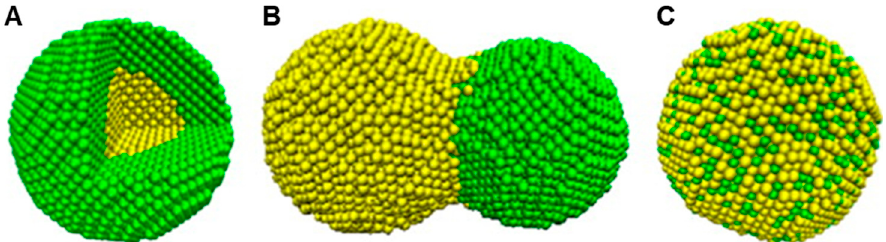
potential of − 36.7 mV.